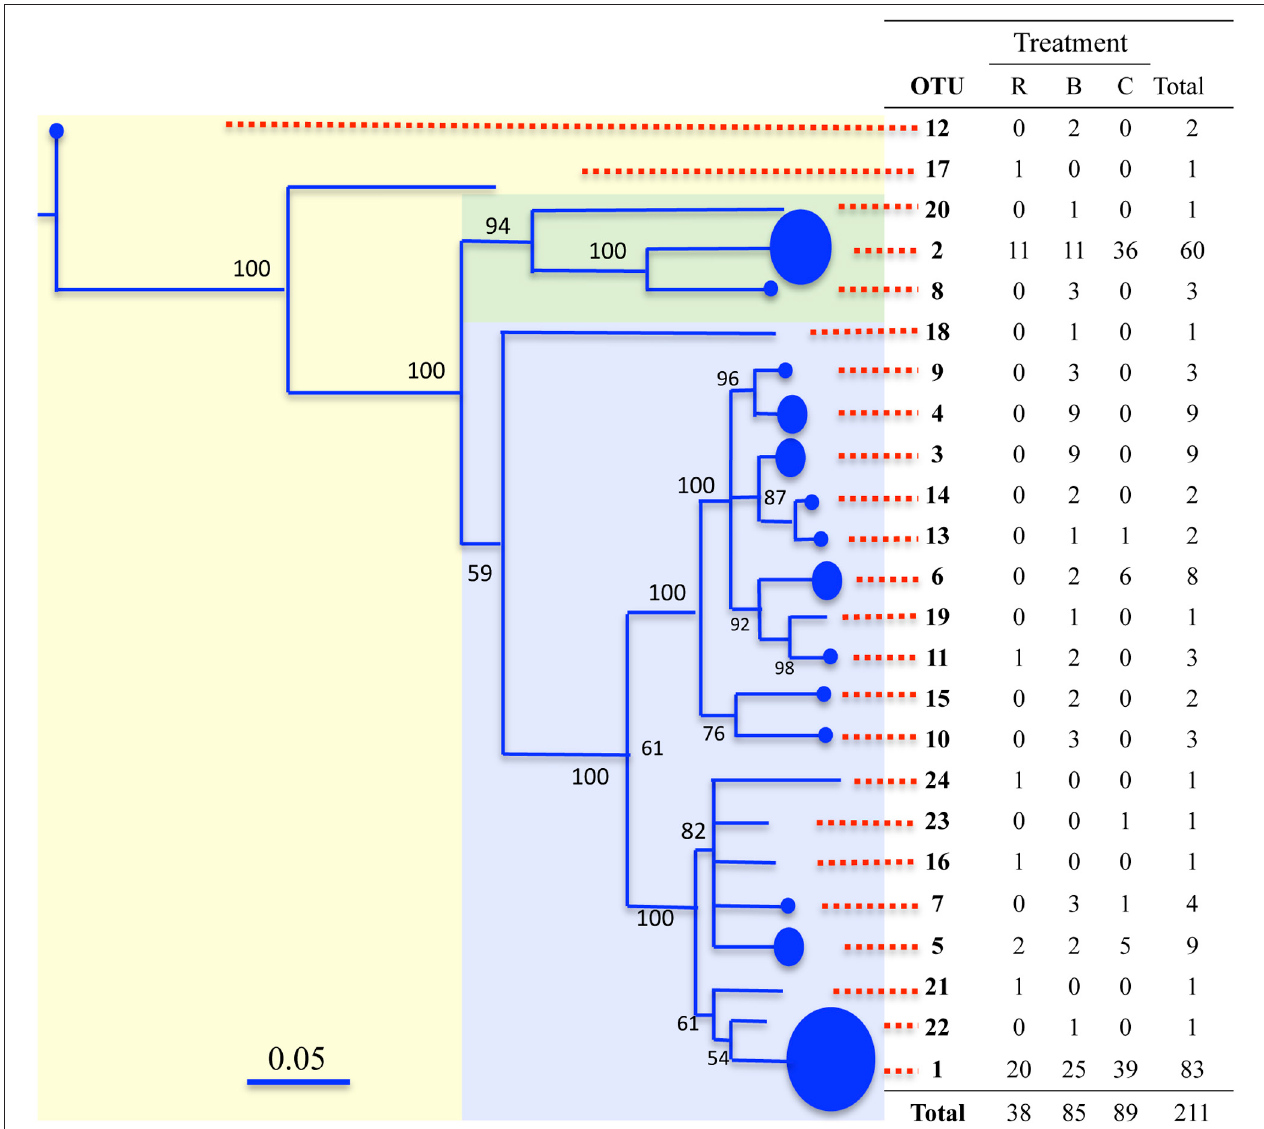
FIGURE 5 | Phylogram of archaeal amoA sequences from the composts. The two main branches are indicated by the light green and blue areas. Each tip is an OTU, and the OTU number is given in the table. The size of circles at the tips is proportional to the number of sequences comprising that OTU,